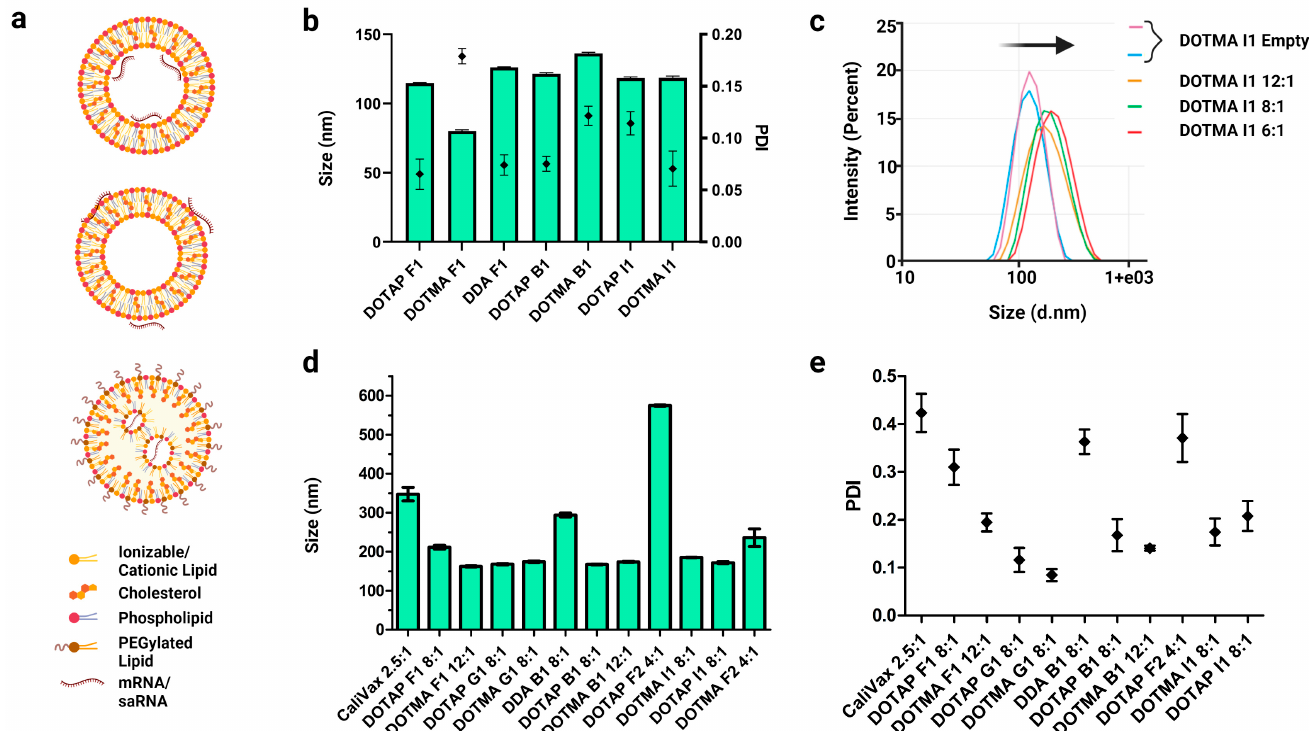
Figure 3. Production of cLNPs by lipid film hydration and external saRNA formulation. ( a ) cLNPs (top and middle) consist of a lipid bilayer, and RNAs can be complexed interiorly (top) or exteriorly (middle). These can also contain a PEGylated lipid. iLNPs (bottom) consist of an electron-dense structure. ( b ) Size and PDI were measured after bath sonication and extrusion. Although sizes were variable, all LNPs were below 150 nm with good PDIs (all < 0.2). ( c ) As saRNAs were added externally to LNPs, size increased with a decreasing N:P ratio (12:1 to 6:1) as shown by the size shift for the DOTMA I1 formulation (arrow). ( d ) When saRNAs were complexed externally, LNP sizes were generally ≤ 200 nm; however, outliers were present, especially at lower N:P ratios. ( e ) PDIs of externally formulated saRNA-cLNPs were generally ≤ 0.3. Lower N:P ratios generally produced higher PDIs. Results are depicted as the mean, with standard error of the mean. Created using GraphPad prism 4 and 5 and